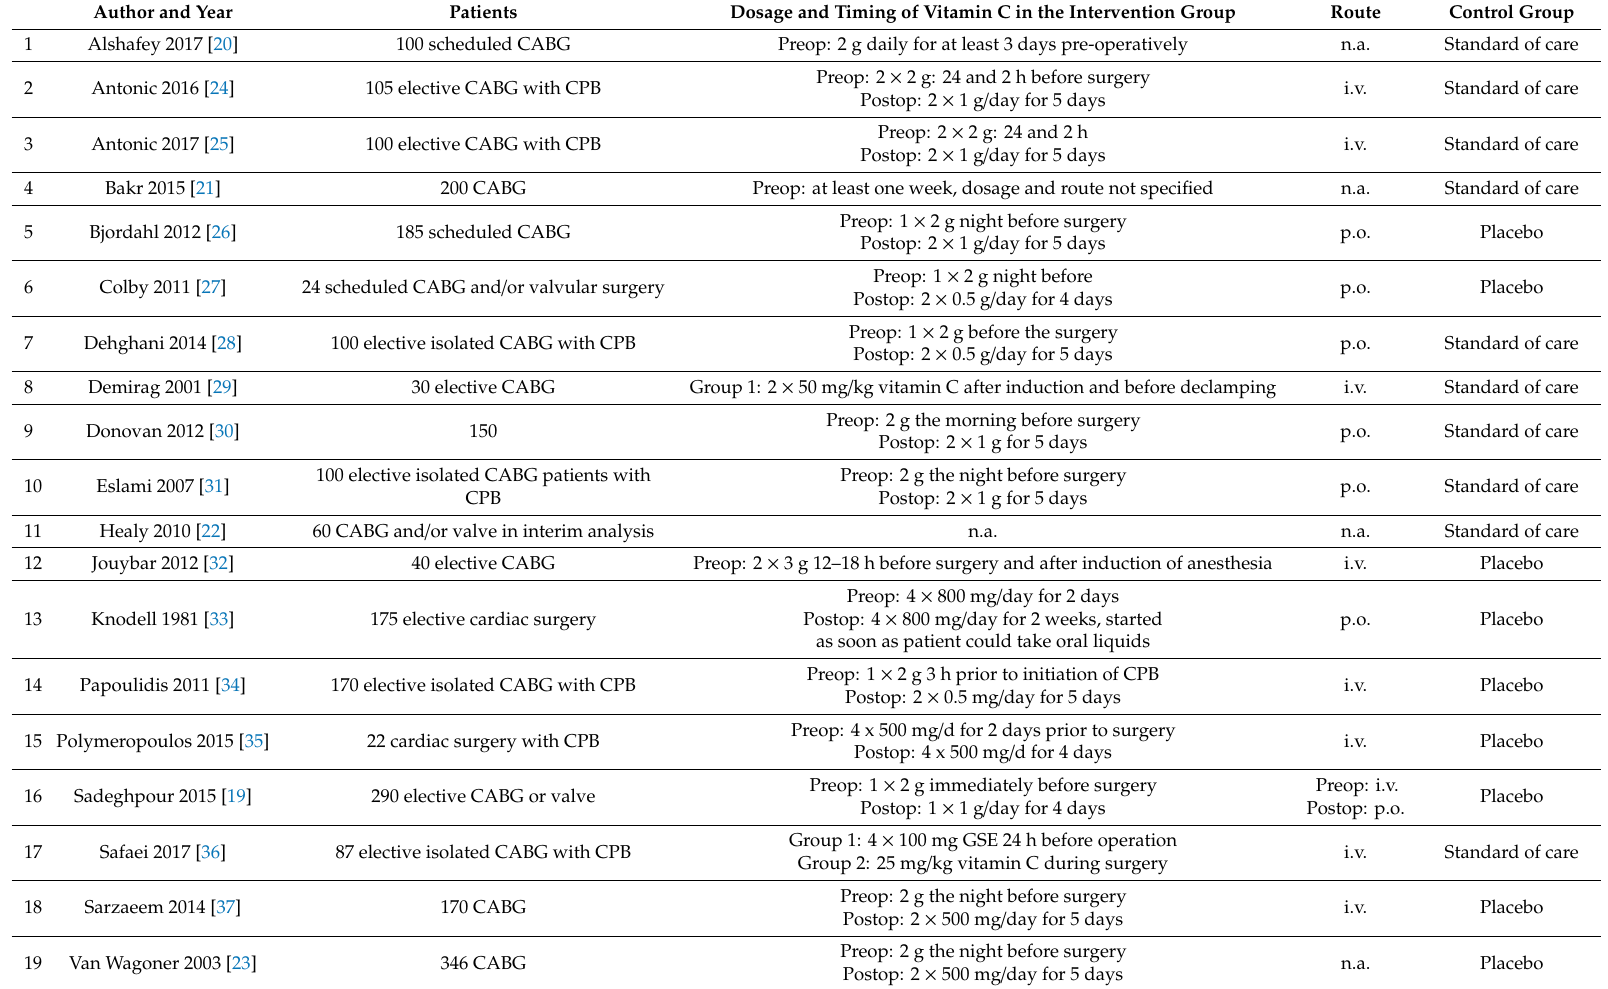
Table 1. Characteristics of included studies, CABG = coronary artery bypass graft, CPB = cardiopulmonary bypass, Vit C = Vitamin C, i.v. = intravenously, p.o. = orally, preop = before surgery, postop = after surgery, n.a. = not